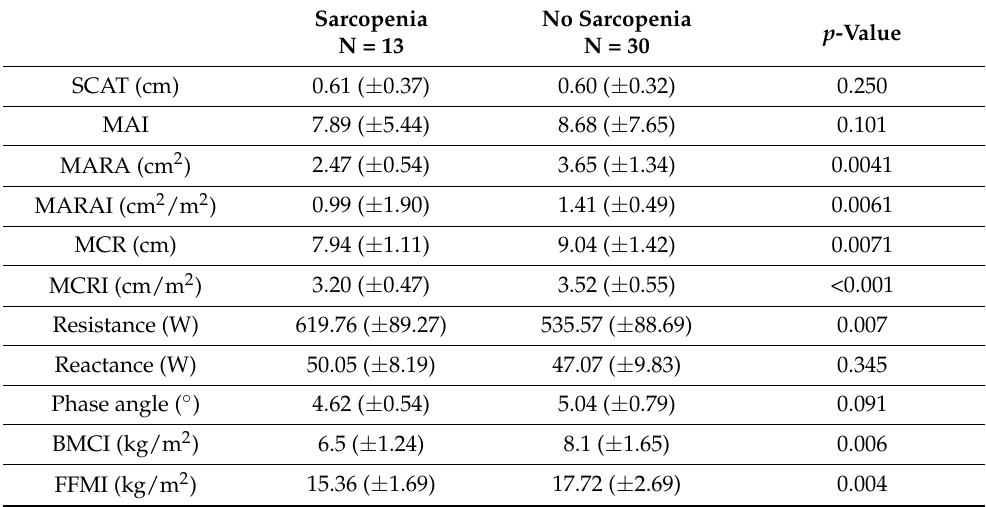
Table 4. Differences between the morphofunctional assessment parameters (ultrasonography and bioimpedanciometry) based on the diagnosis of sarcopenia using EGWGSOP2 criteria.